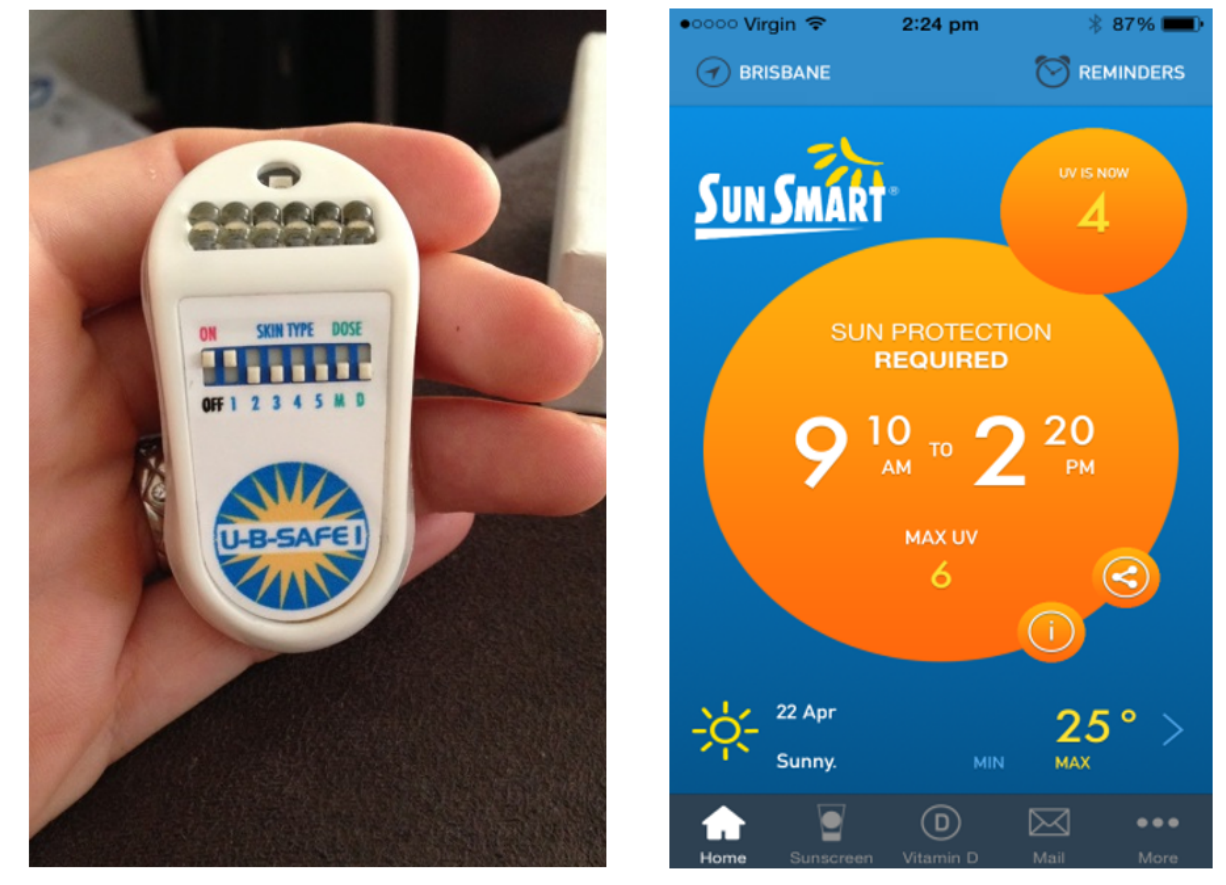
Figure 2. Intervention devices; left: personal ultraviolet radiation dosimeter monitor (Healthtronics SunSafe Pty Ltd, Australia); right: SunSmart app (Cancer Council Victoria,